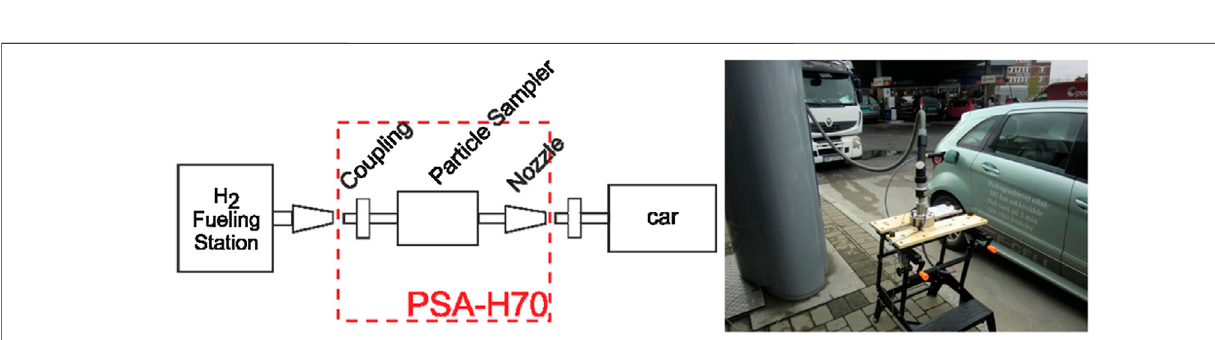
Frontiers in Energy Research |